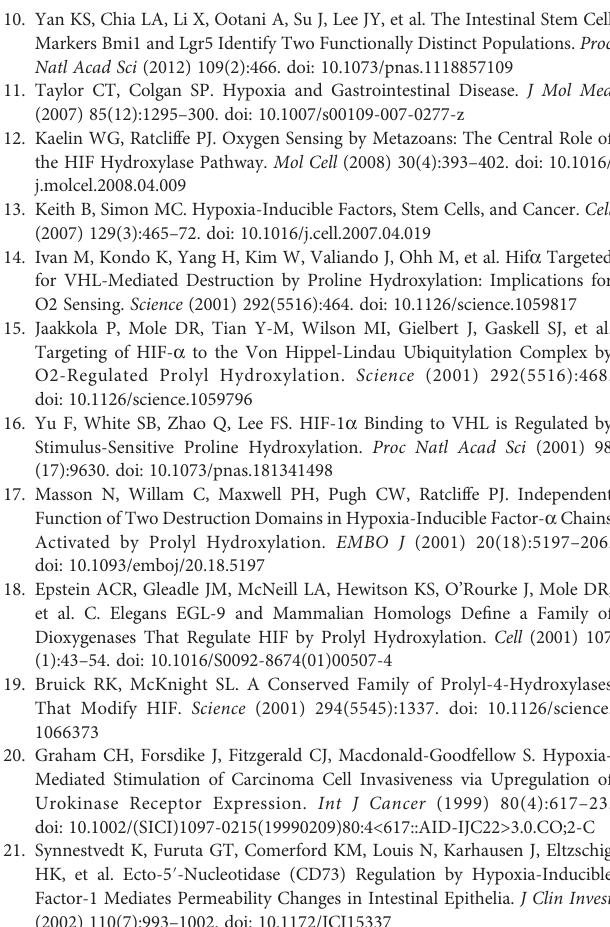
Adeno-GFP evaluated via RNA sequencing (n = 3 biological replicates/group). (B) Volcano plot of the differentially expressed genes. Supplementary Figure 2 | Sequences of the Human WNT5A promoter WT and HRE mutant constructs used for this study. Supplementary Figure 3 | Wnt5a does not a mitigate radiation-induced intestinal crypt cell death. (A) (CBRLuc-mCherry duodenal reporter organoids treated with vehicle (PBS) or 1 m g/ml rWnt5a for 10h were exposed to the indicated doses of ionizing radiation, and then were treated with rWnt5a again immediately after the spheroid formation assay was seeded, and 48h later. Bioluminescence was measured 6 days post-radiation (n = 3 per group). Continuous rWnt5a treatment does not improve clonogenic capacity of CBRLuc-mCherry organoids exposed to radiation. (B) CBRLuc-mCherry duodenal reporter organoids were exposed to the indicated doses of ionizing radiation, and then were treated with vehicle (PBS) or 1 m g/ml rWnt5a for 5h and 48h after irradiation. Bioluminescence was measured 6 days post-radiation (n = 3 per group). Post-radiation rWnt5a treatmentdoesnotimproveclonogeniccapacityofCBRLuc-mCherryorganoids.All error bars represent mean ± SEM. *P < 0.05, by Student ’ s t test. Supplementary Figure 4 | Wnt5a is necessary for crypt regeneration in response to radiation. Wnt5a fl / fl duodenal organoids infected with Adeno-Cre-GFP or Adeno-GFP and were then exposed to the indicated doses of ionizing radiation. Z-stack images were stitched and organoids larger than 150 m m in diameter were quanti fi ed 6 days post-radiation (see Figure 5E for mean surviving fraction values; n = 3 per group). Representative bright fi eld Z-stack images are